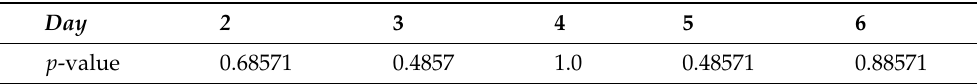
Table 6. Wilcoxon–Mann–Whitney test between baseline (first day) and the following days, among all the